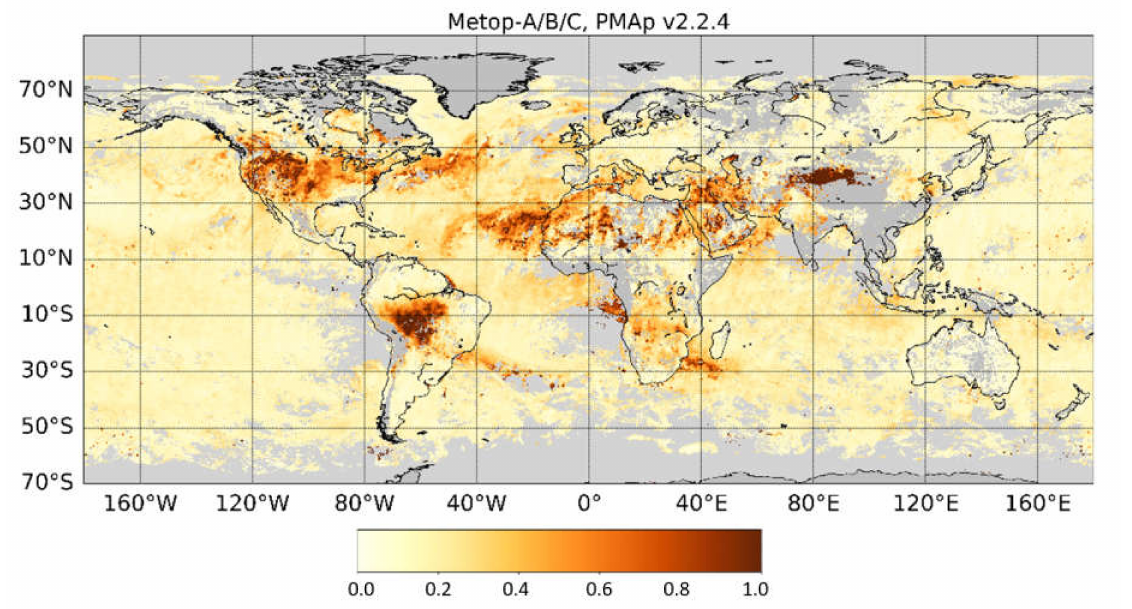
Figure 7. Average AOD derived from PMAp for Metop-A, B, and C on 10–21 September